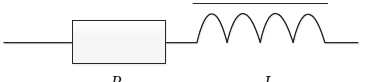
Figure 2: The equivalent circuit model of magnetoimpedance effect.